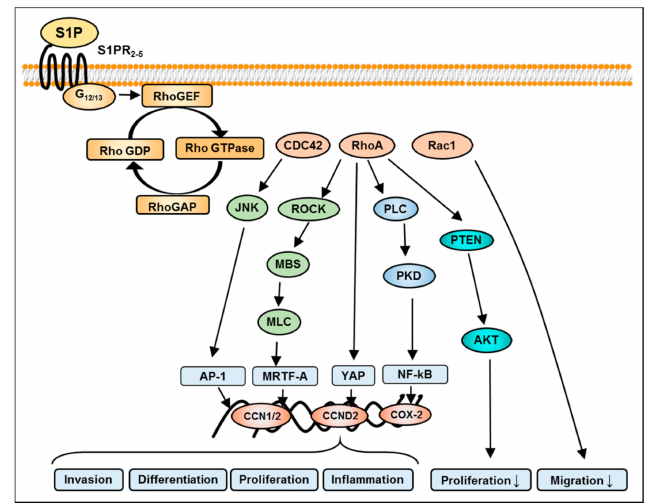
Figure 3. Graphic of S1PR pathways involved in RhoA (Ras homolog gene family, member A) and transcription factor activation in glioma cells. A Rho-like subfamily has been identified which becomes activates via the stimulation of G12/13-protein subunit of S1PRs. The guanine nucleotide exchange factor activates downstream signaling intermediates such as Rho GTPases (guanosine triphosphate hydrolase enzymes) namely CDC42 (cell division control protein 42 homolog), RhoA, and Rac1 (Ras-related C3 botulinum toxin substrate 1). An Rho-kinase-dependent increase in the phosphorylation of the myosin light chain (MLC) by inhibiting the myosin-binding subunit (MBS) causes myofibril reorganization, contraction, and activation of downstream transcriptional effectors. The RhoA-mediated (Ras homolog gene family) transcriptional network involves activator protein 1 (AP1), yes-associated protein (YAP), myocardin-related transcription factor A (MRTF-A), and nuclear factor kappa-light-chain-enhancer of activated B cells (NF-kB). Resulting target genes are involved in the regulation of invasion, proliferation, and differentiation of glioma cells. Inversely, nuclear phosphatase and tensin homolog (PTEN) expression can reduce AKT phosphorylation and consequently inhibit proliferation. On the other hand, Rac1 inhibits migration. Additional abbreviations used in the figure are defined as follows: GEF, guanine nucleotide exchange factor; PKD, protein kinase D; ROCK, RhoA kinase; SRF, serum response factor; ↓